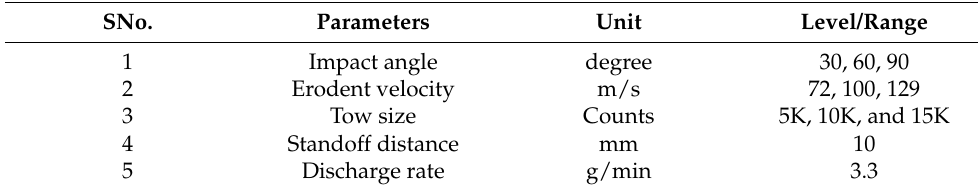
Figure 2. Erosion test facility. Table 2. Control factors and their